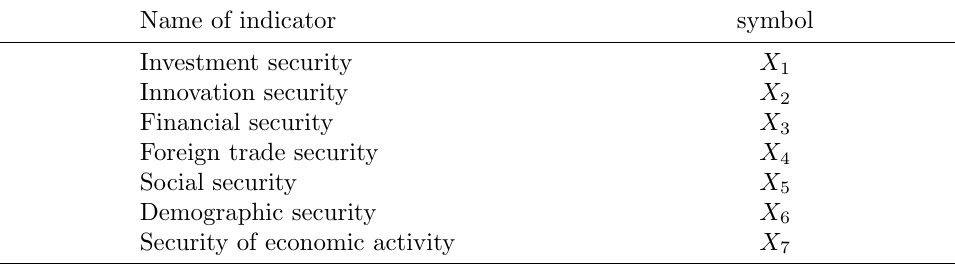
Table 2: Indicators (aggregated influencing factors) for assessing the economic security of a region